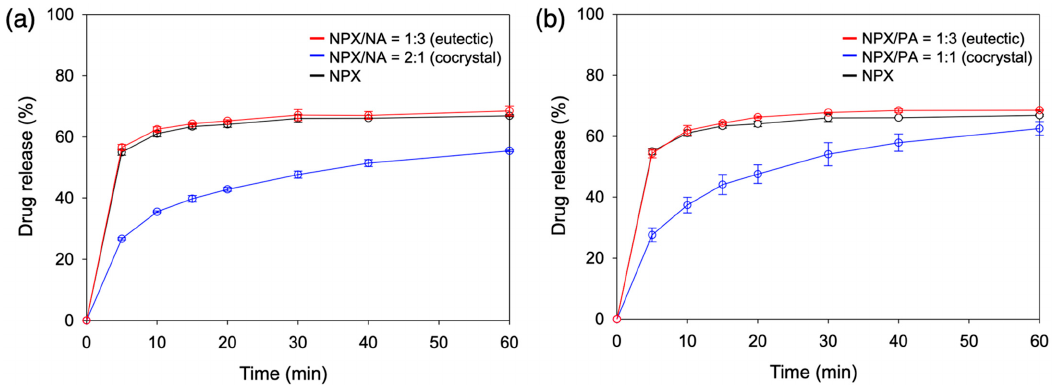
Figure 7. Dissolution profiles (fed state simulated intestinal fluid (FeSSIF), 60 min, n = 3) of ( a ) NPX/NA and ( b ) NPX/PA. Eutectics and cocrystals are compared with neat NPX.